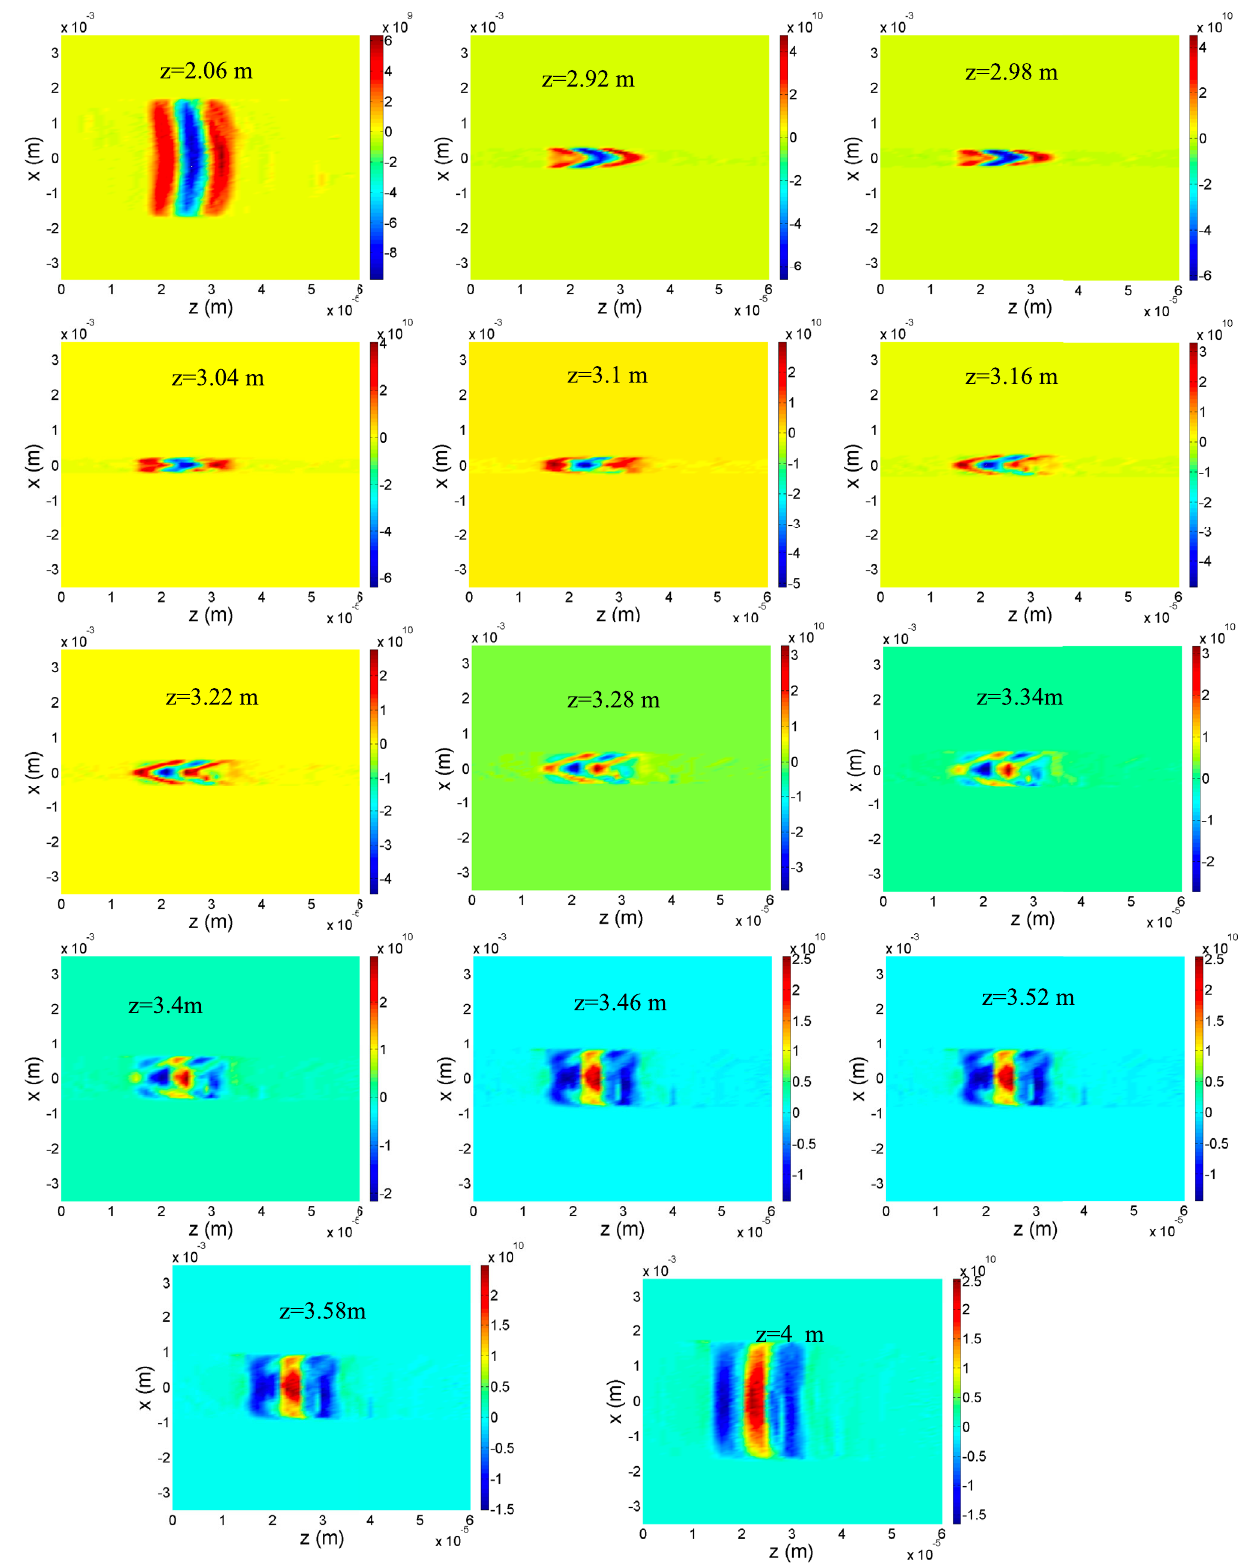
FIG. 10. Case 1: evolution of the single spike in density modulation in the second cell of the test PCI lattice. Two mode structures are visible at z ranging from 3.3 to 3.5 m. Note the reversal of the sign of the density modulation for the central slice, when compared with the first